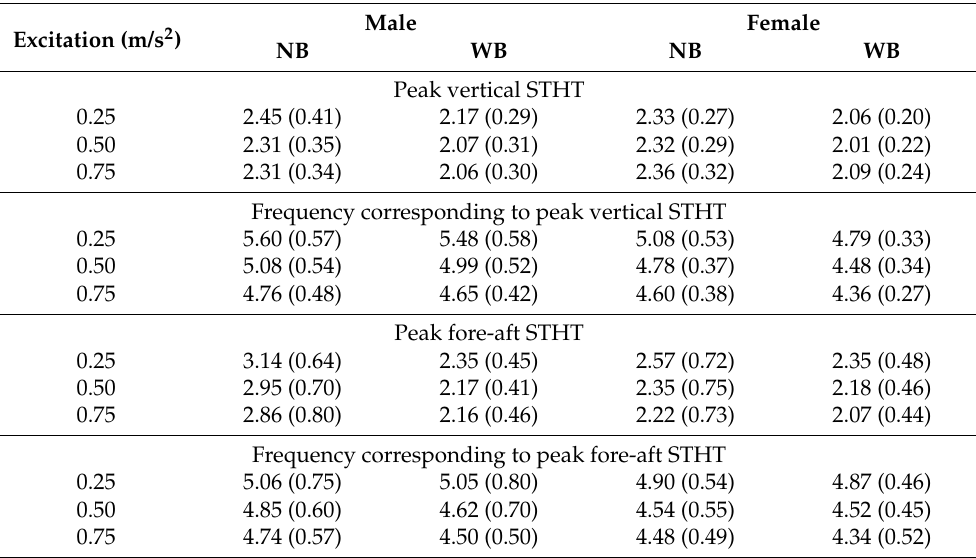
Table 3. Means (standard deviations) of peak STHT magnitudes and the corresponding frequencies of the 31 male and 27 female subjects for the two sitting conditions and three levels of excitation. Excitation (m/s 2 )